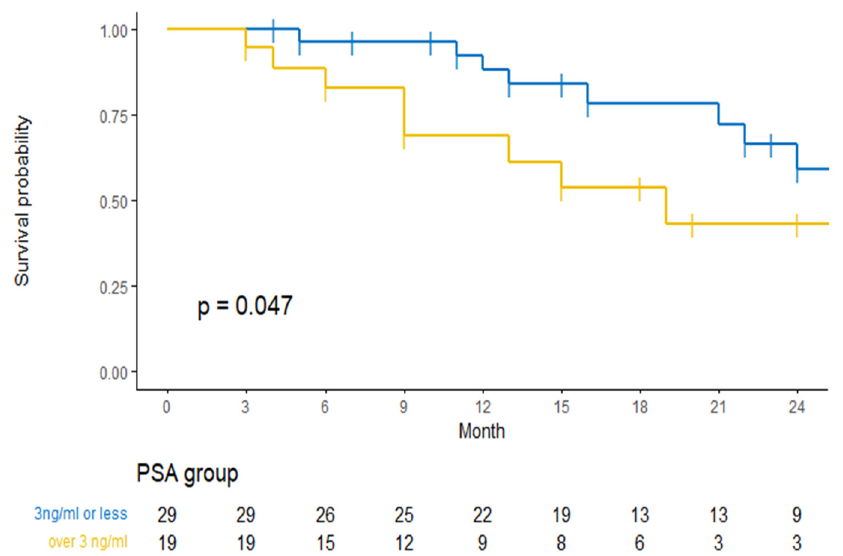
Figure 3. Biochemical relapse-free survival according to the pre-SBRT PSA level. SBRT-stereotactic body radiation therapy; PSA-prostate specific antigen.